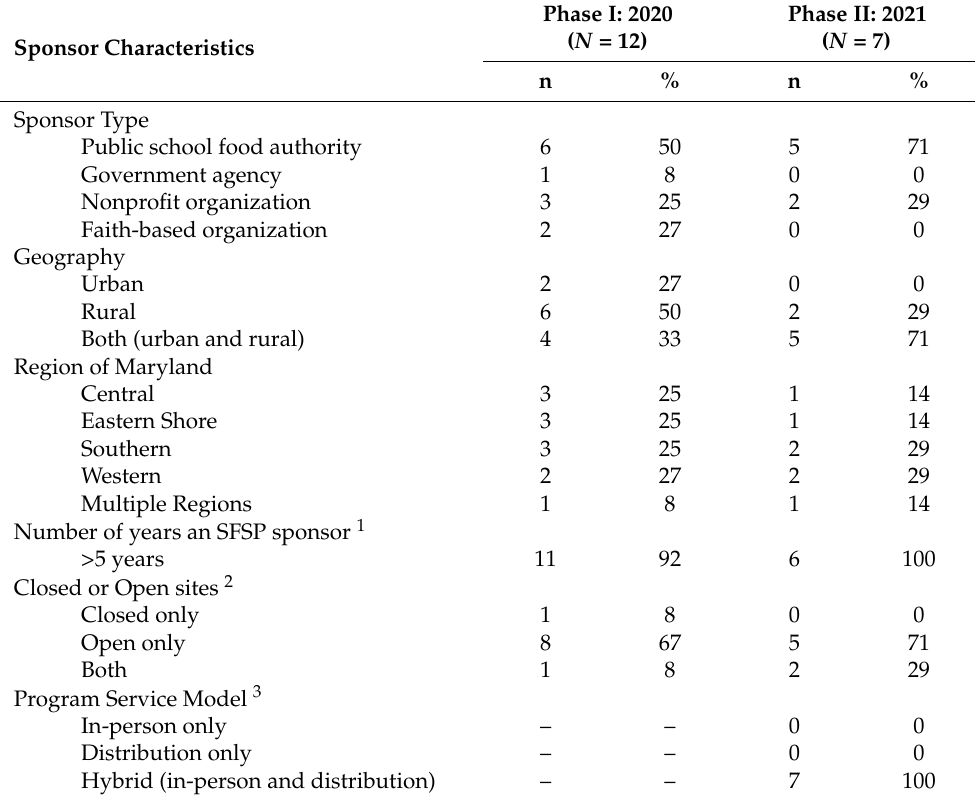
Table 3. Maryland 2020 and 2021 Summer Food Service Program (SFSP) sponsor interview participant